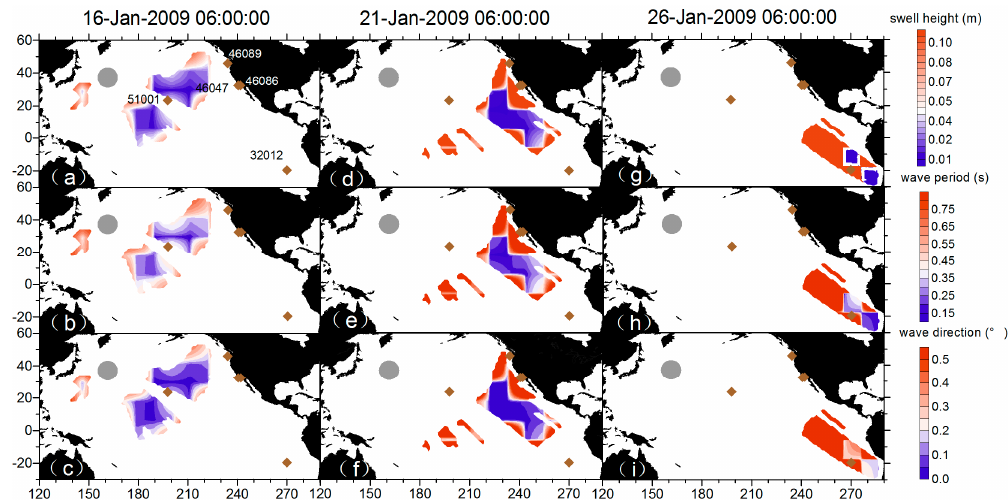
Figure 11. Snapshots of the spreads of swell height, period, and direction at 16-, 21-, and 26-Jan-2009 06:00:00.